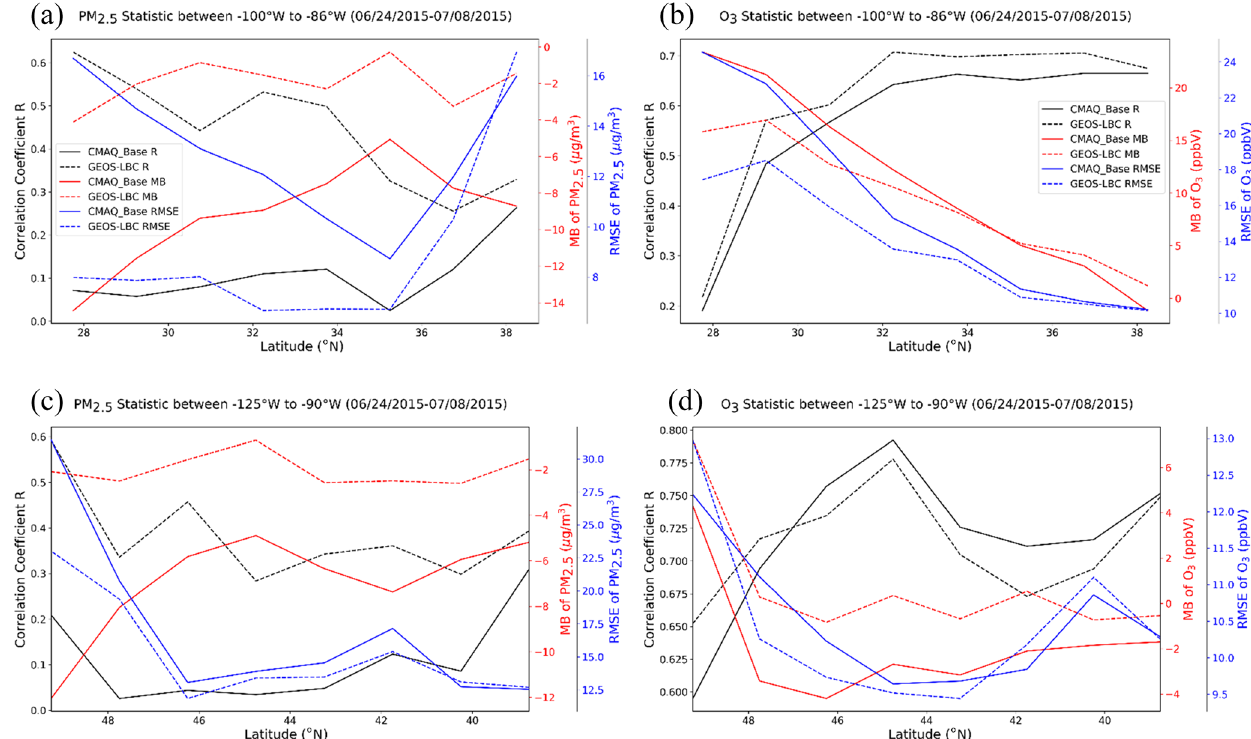
Figure 11. The latitudinal distributions of correlation coefficient R (black), mean bias (MB) (red), and root mean square error (RMSE) (blue) of PM 2 . 5 (a, c) and O 3 (b, d) concentrations from 24 June to 8 July 2015 over the southern USA (a, b) and northern USA (c, d) for CMAQ_Base (solid line) and GEOS-LBC (dash line) runs. Please note that the dates in this figure are given in the format of month day year